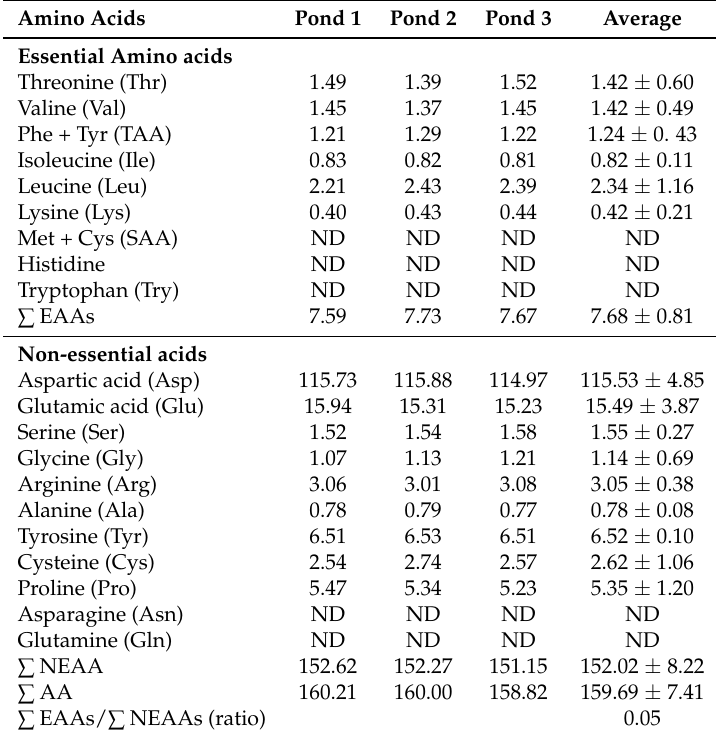
Table 4. Amino acid content in cultivated C. racemosa (mg g − 1